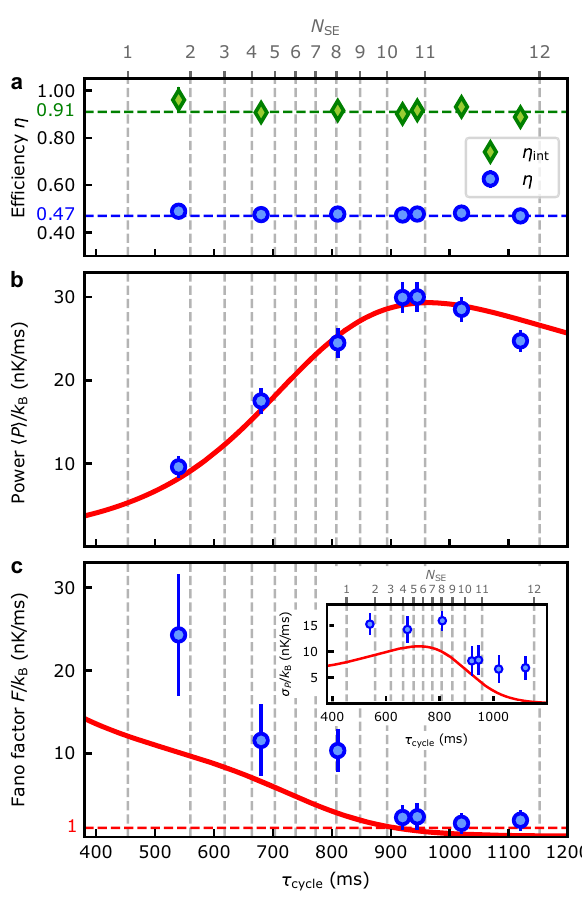
Fig. 3 Performance of the quantum heat engine. a Ef fi ciency η , Eq. (2) (blue dots), and internal (dissipationless) ef fi ciency η int (green diamonds) for different cycle times; dashed lines indicate the respective expected values. b Average power output, Eq. (3) (blue dots: experimental data, red solid line: theoretical model), with maximal value reached after almost 12 spin exchange collisions. c Fano factor, Eq. (4), and time-resolved fl uctuations σ P (inset). In all cases, the dashed vertical lines (upper axis) indicate the number of spin-exchange collisions N SE . The different durations between two successive spin-exchange collisions originate from different atomic transition rates 14 . Error bars show statistical uncertainty of ± 1 σ standard deviation.